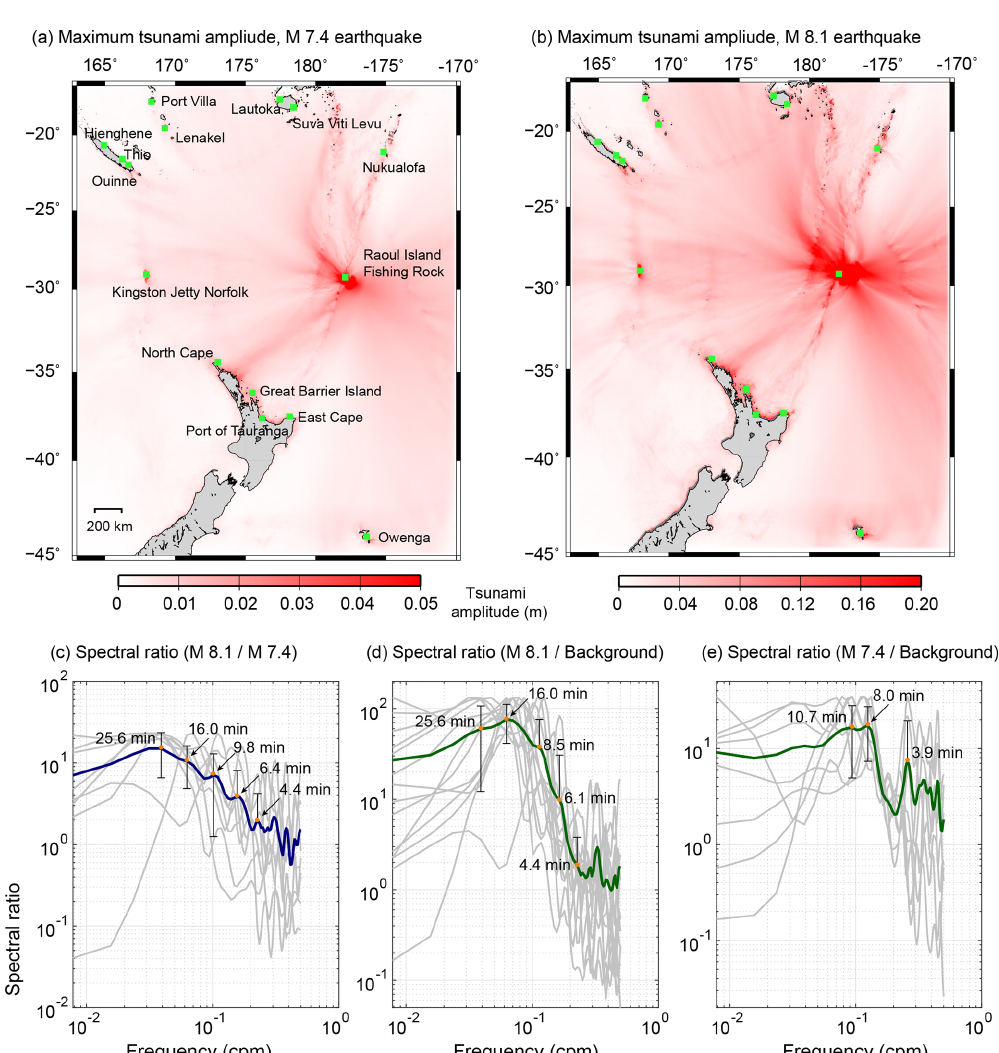
Figure 5. (a, b) Maximum simulated amplitudes for two tsunamis during the entire simulation time. The source models used for numerical simulation are from the USGS. (c) Spectral ratio of two tsunamis by dividing the spectral energy of the second tsunami to that of the first tsunami (EGF method). Blue curve is the normalized average of tsunami spectral energy at different tide gauges. (d) Spectral ratio of the second tsunami spectrum to the background signal spectrum. Green curve is the normalized average of different tide gauges. (e) Spectral ratio of the first tsunami spectrum to the background signal spectrum. Green curve is the normalized average of different tide